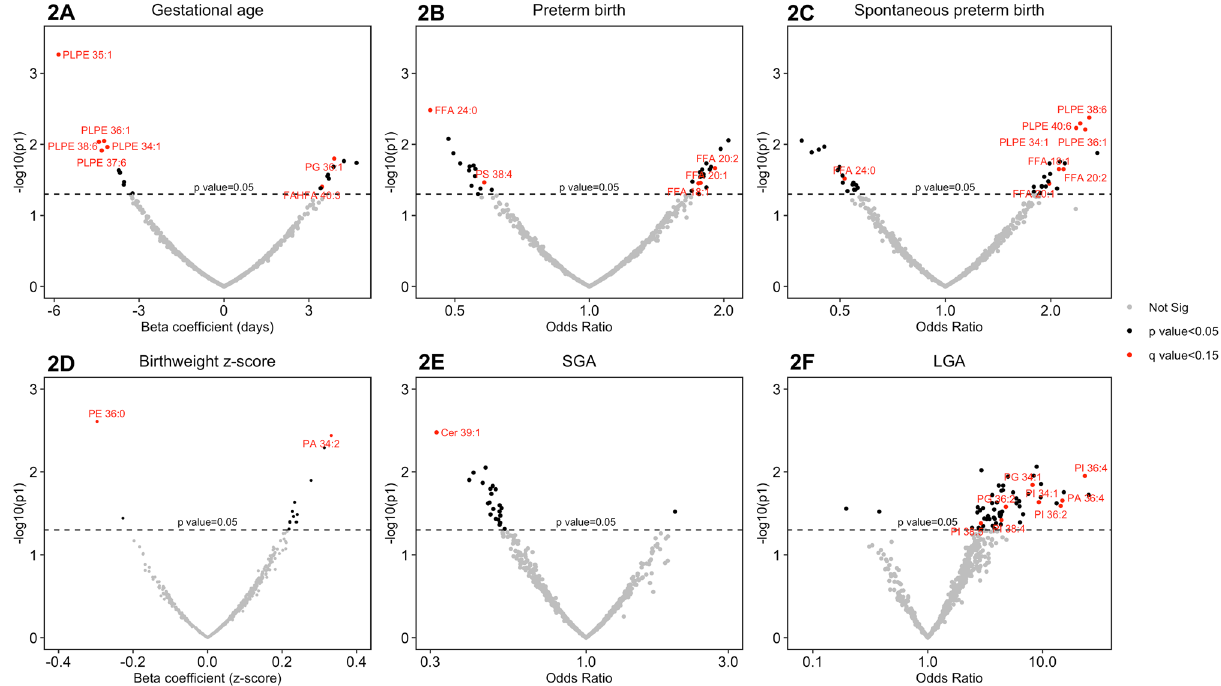
Figure 2. Volcano plots of associations [-log 10 (p-values)] between lipidome-wide metabolites and pregnancy outcomes: ( A ) gestational age at delivery; ( B ) preterm birth (n cases = 31,n controls = 69); ( C ) spontaneous preterm birth (n cases = 19,n controls = 69); ( D ) birthweight z-score; ( E ) small for gestational age [SGA] (n cases = 16,n controls = 75); ( F ) large for gestational age [LGA] (n cases = 9,n controls = 75). Point estimates labeled in red are those that were adjusted for false discovery rate (q-value < 0.15). Models adjusting for maternal age, maternal education, fetal sex, pre-pregnancy BMI, and weight increased risk (Fig. 2C). There was one free fatty acid that was associated with lower risk of spontaneous preterm birth (Fig. 2C). For the continuous outcome birthweight z-score, one lipid metabolite from the phosphatidic acid class was associated with higher birthweight z-score while one metabolite from the phosphatidylethanolamine class was associated with lower birthweight z-score (Fig. 2D). Contextualizing neonatal size by gestational age revealed one ceramide lipid that was associated with decreased risk of being small for gestational age at delivery (Fig. 2E). Conversely, five lipids from the phosphatidylinositol class, two from the phosphatidylglycerol class, and one from the phosphatidic acid class were associated with increased risk for being large for gestational age at delivery (Fig. 2F). Across all of the phenotypes that we focused on, we observed very little overlap in associated lipid metabolites between preterm birth and the fetal anthropometric outcomes. Saturation subgroup associations with pregnancy phenotypes. Figures 3A–F are forest plots of associations with pregnancy phenotypes upon summation of individual lipid metabolites based on the degree of saturation in hydrocarbon tails. For gestational age at delivery, we observe only saturated plasmenyl-pho- phatidylethanolamines were associated with decreased gestational age at delivery (Fig. 3A). Three different lipid subgroups (mono-unsaturated free fatty acids, poly-unsaturated diglycerides, and saturated plasmenyl- phophatidylethanolamines) were associated with increased risk for overall preterm birth (Fig. 3B). Focusing on spontaneous preterm birth, we observed that mono- and poly-unsaturated free fatty acids, saturated ceramides, and saturated plasmenyl-phosphatidylethanolamines were all associated with increased risk (Fig. 3C). Saturated ceramides were associated with higher birthweight z-score (Fig. 3D). At this level of lipid organization, we did not observe any notable associations with small-for-gestational age at delivery (Fig. 3E). However, saturated and mono-unsaturated phosphatidylglycerols, and mono- and poly-unsaturated phosphatidylinositols were associ- ated with increased risk for large-for-gestational age at delivery (Fig. 3F).